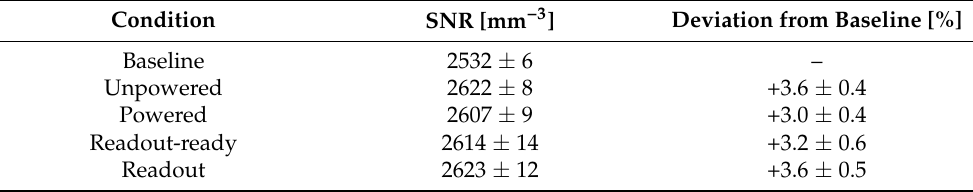
Table 1. SNR values observed in baseline and interference measurements (low decay rate).